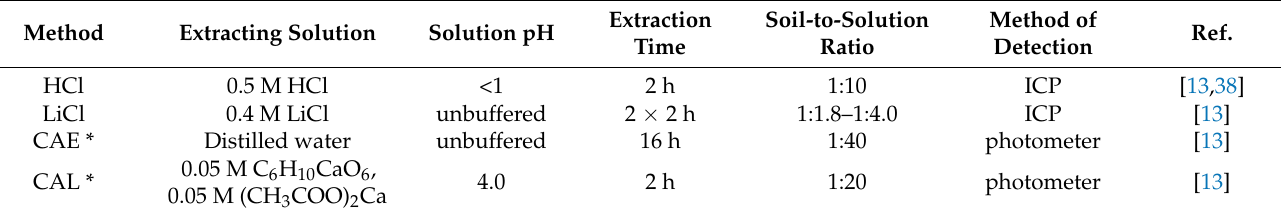
Table 4. Overview of soil P extraction